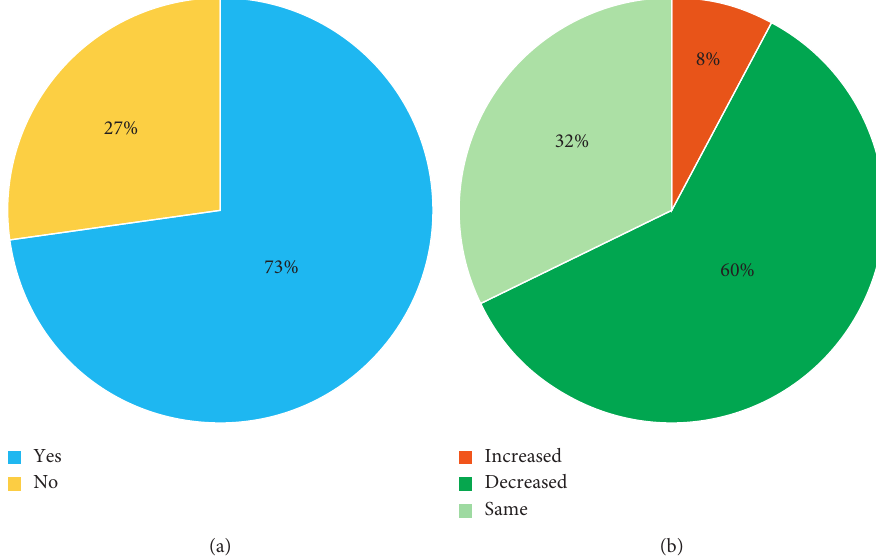
Figure 4: Improvement in function (a) and change in medication (b) in patients with > 12 months follow-up ( N � 51 and 47 patients,